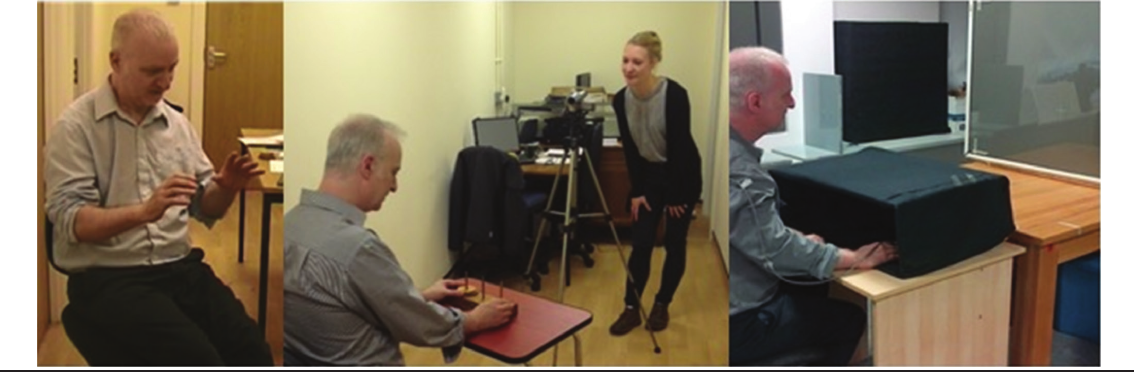
Figure 2. Matthew regularly visits the BEAM lab to advise on how to make testing sessions for people with Parkinson’s comfortable and easy to understand, including trying out communicative, cognitive (thinking) and movement tasks (Source: Authors,